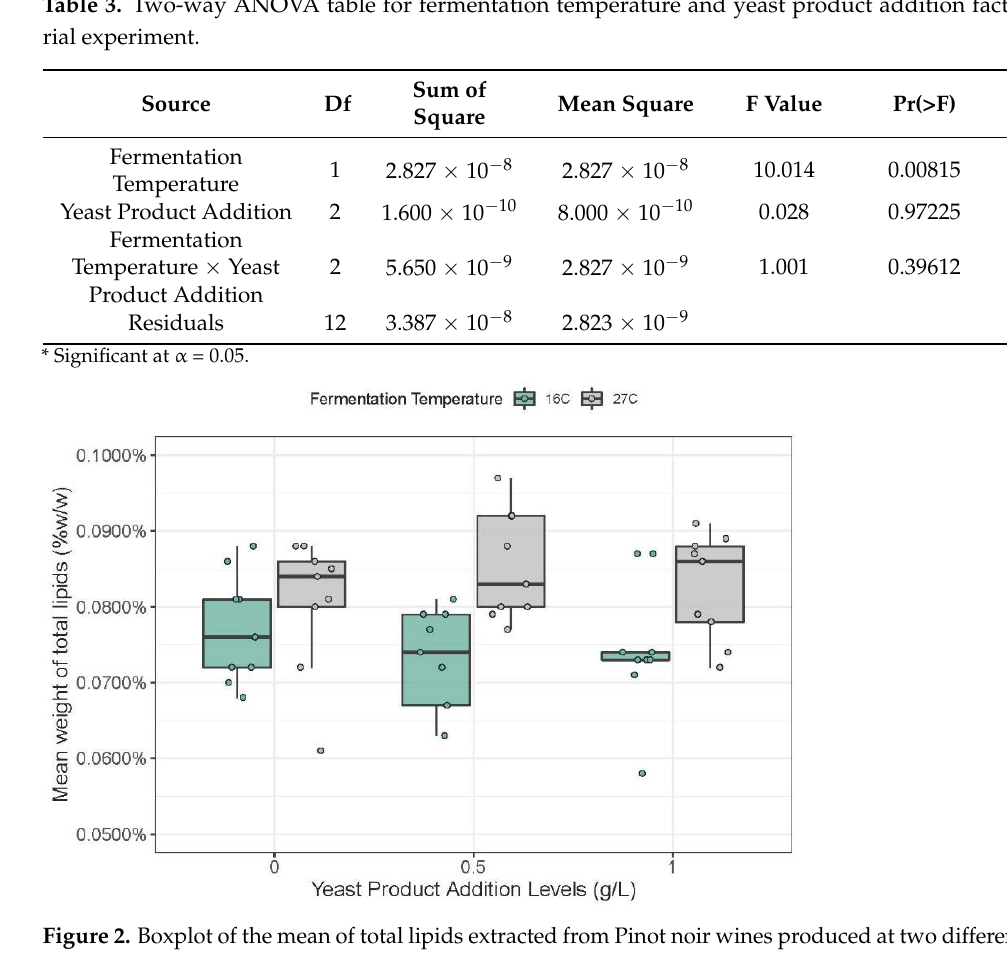
FFA 22:0, FFA 16:0 and FFA 18:1 were the highest. See Table 4 for lipid abbreviations and classification names. Table 4. Abbreviations for each lipid class found in the Pinot noir wines.